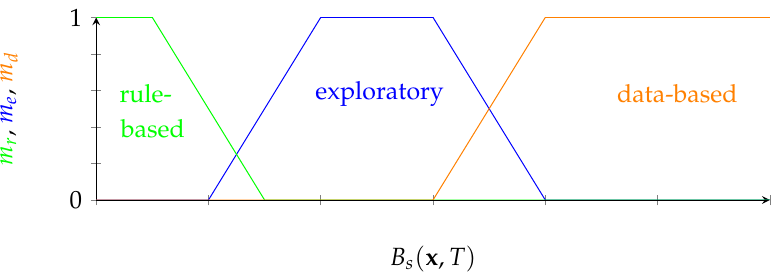
Figure 5. The membership classes based on the value of B s ( x i , T ) . Instead of a space, the behaviour preference can also be presented as one value B s ( x i , T ) , which combines the aspects of information level and user